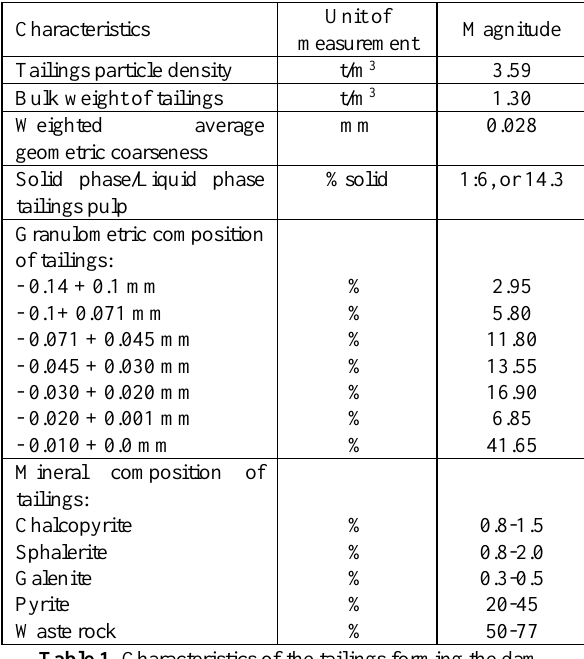
Table 1 . Characteristics of the tailings forming the dam.